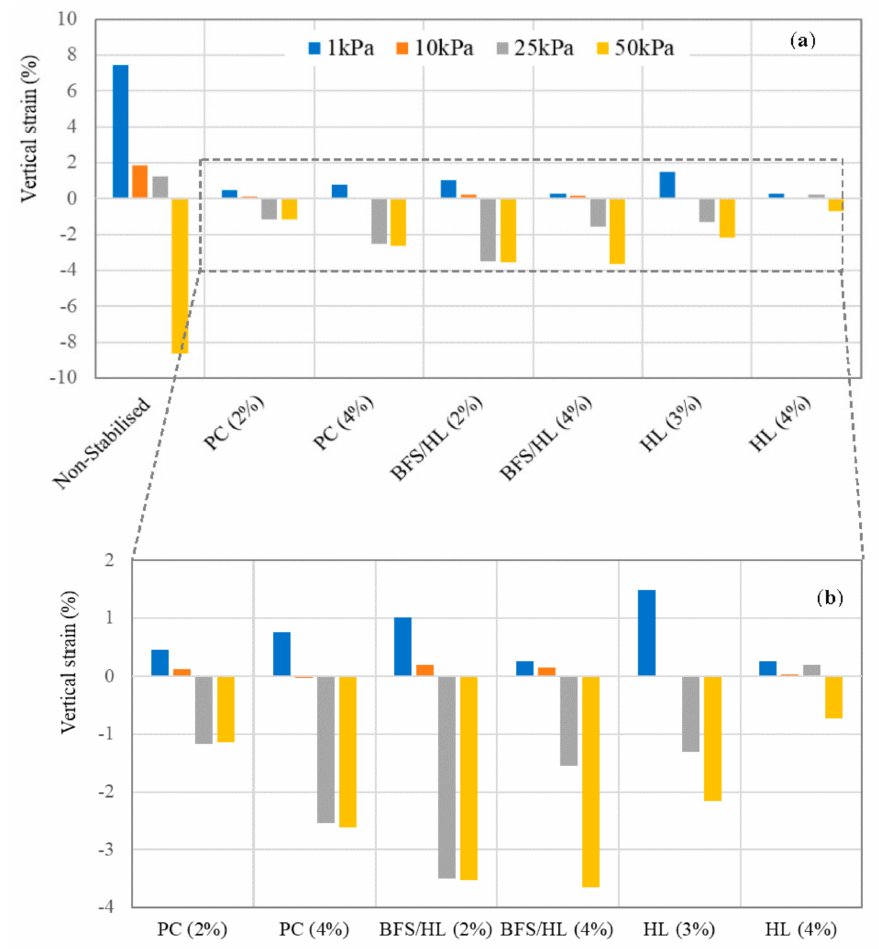
Figure 6. Summary of the ( a ) vertical strains obtained in the swelling tests under various vertical stresses, i.e., positive values indicate swelling whereas negative values indicate consolidation and ( b ) magnification of the results for specimens